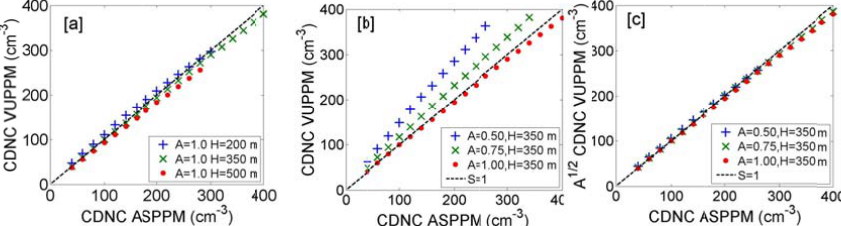
Fig. 13. Comparison of retrieved cloud drop number concentration (CDNC) from VUPPM with